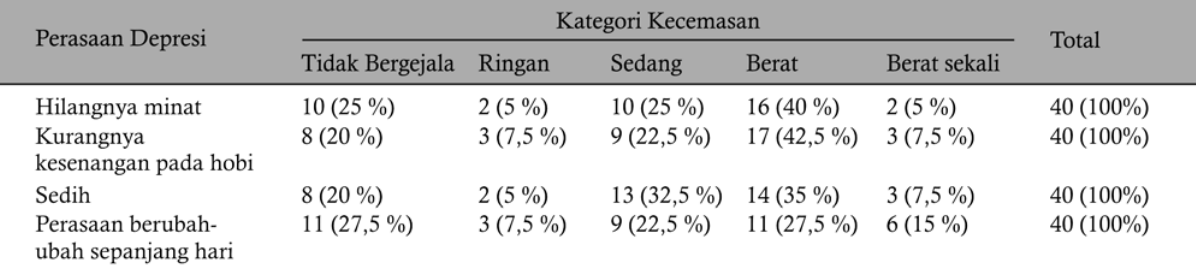
Tabel 14. Distribusi Frekuensi Kecemasan Berdasarkan Perasaan Depresi